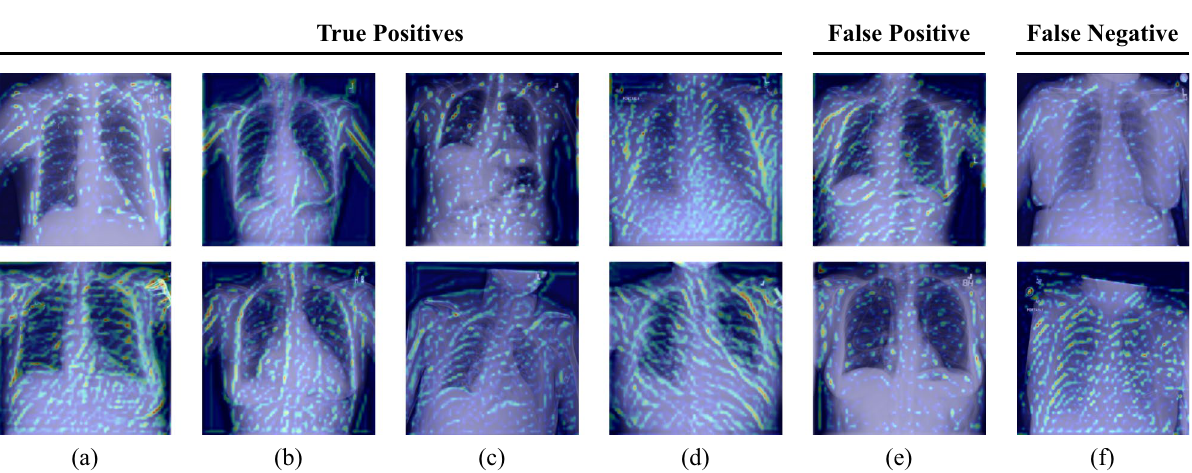
Figure 7. Grad-CAM visualizations for an intermediate convolutional layer of the ResNet-50 incorporated in our SNN. Each column represents one image pair. The first four columns ( a – d ) show true positive classifications. The last two columns ( e ) and ( f ) depict a false positive and a false negative classification, respectively. The obtained attention maps clearly illustrate that the selected network layer focuses on the ribs and the outline of the